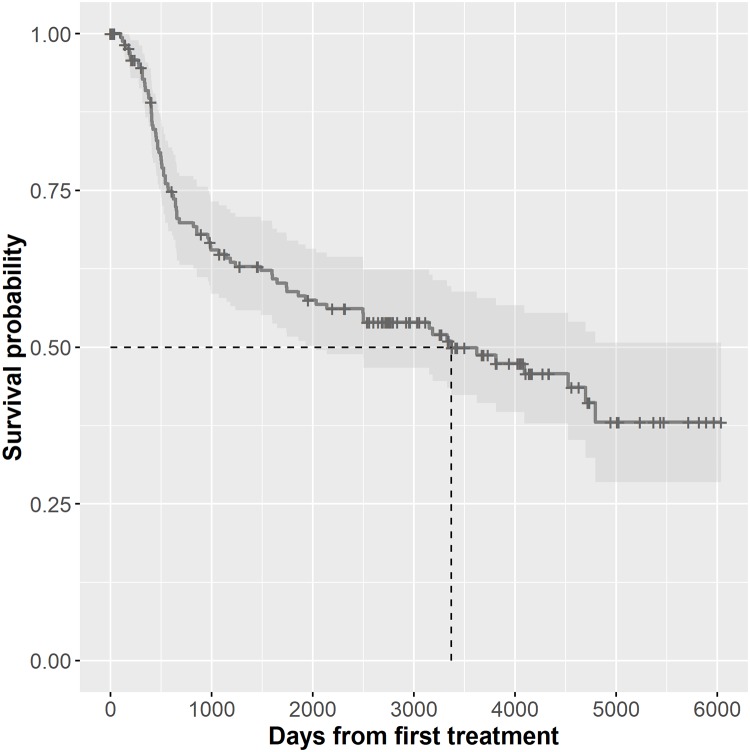
Survival probability.Representation of the Kaplan Meyer curve with the median of the probability of survival.